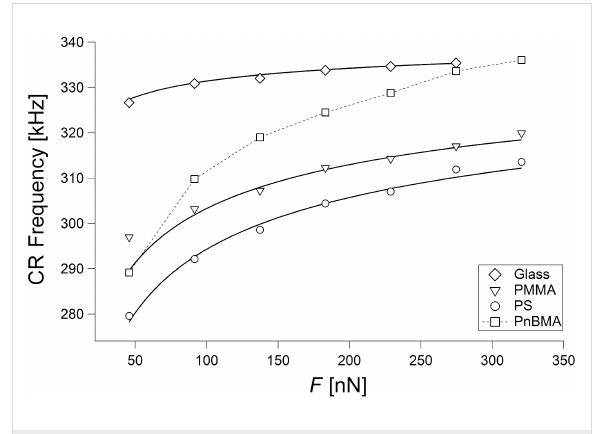
Figure 6: CR frequencies as a function of the force F on glass (diamonds), bulk PMMA (triangles), and bulk PS (circles), fitted with Equation 16 (black curves). CR frequencies on PnBMA (squares) are shown,